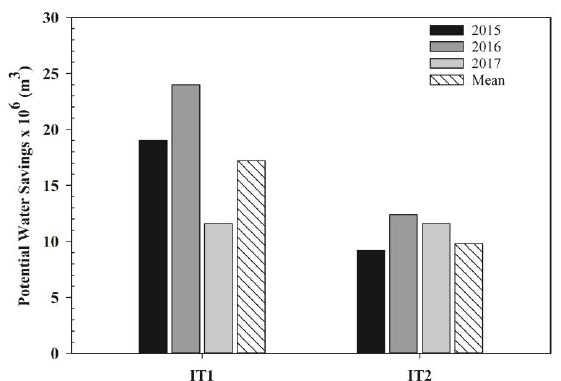
Figure 5. Potential water savings through adoption of earlier irrigation terminations in the Lugert-Altus Irrigation District.